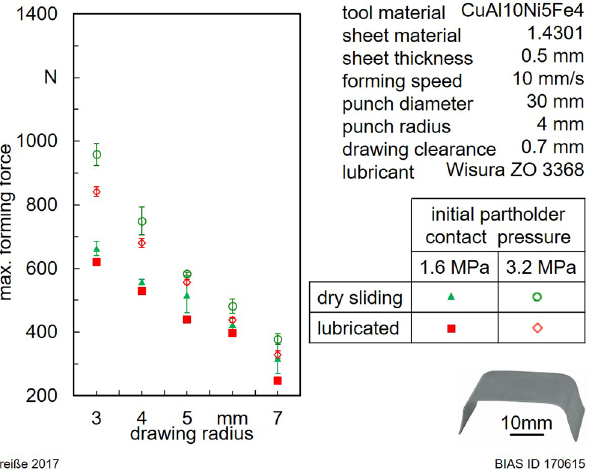
Fig. 13. Maximum forming forces using bronze tool under variation of the drawing radius.